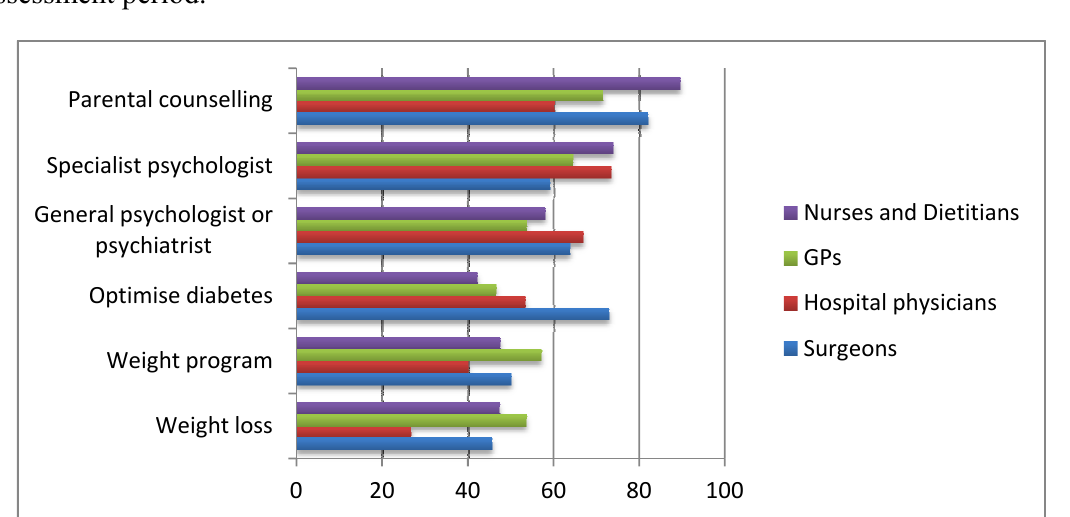
Figure 1. Compulsory prerequisites to bariatric surgery in adolescents during the assessment